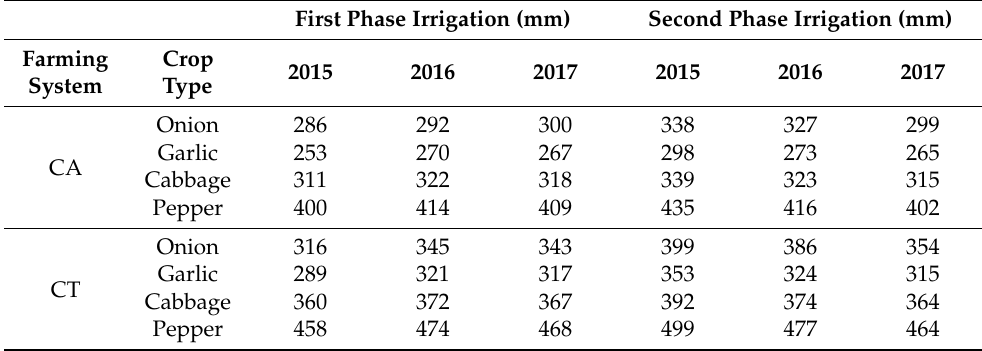
Figure 10. Monthly evapotranspiration from 2014 to 2018. Table 2. Crop evapotranspiration (mm) for onion, garlic, cabbage, and pepper under a conservation agriculture (CA) and conventional tillage (CT) experiment conducted during two irrigation seasons: first phase (October–February) and second phase (March–June). First Phase Irrigation